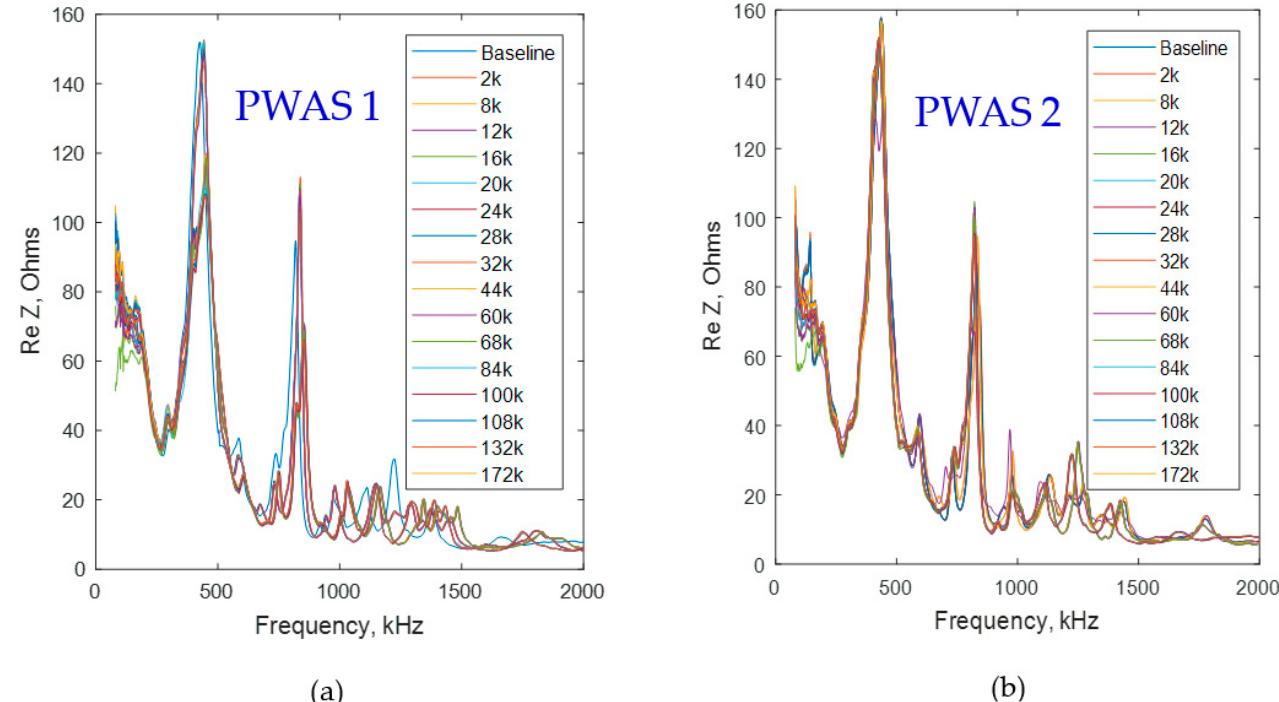
Figure 7. EMIS measurement of 172 kcycles of the fatigue–crack–growth experiment. ( a ) EMIS measurement of PWAS 1 ( b ) EMIS measurement of PWAS 2. Very similar trends of EMIS spectrograms were observed during 172 kcycles. This confirmed that the PWAS bonding was in good condition during the fatigue–crack–growth experiment.